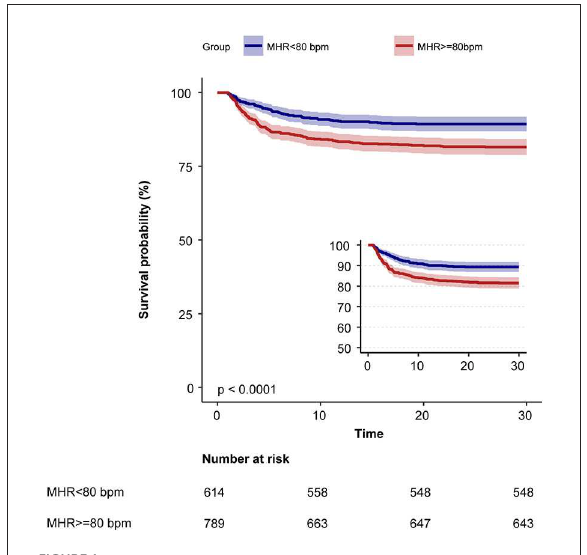
FIGURE1 Kaplan–Meier survival curves for day 30 of ischemic stroke patients with atrial fibrillation. MHR, mean heart rate; bpm, beats per minute.